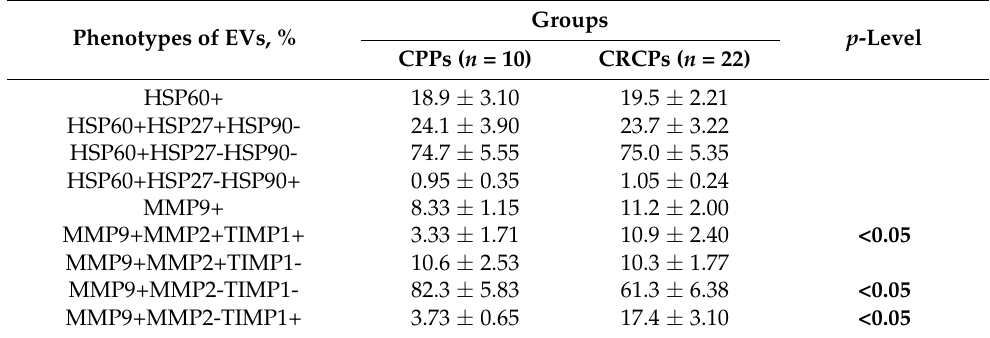
Table 2. MMP and HSP composition on the surface of FABP4-positive sEVs in blood plasma in CPPs and CRCPs, mean ± SE *. Phenotypes of EVs, %